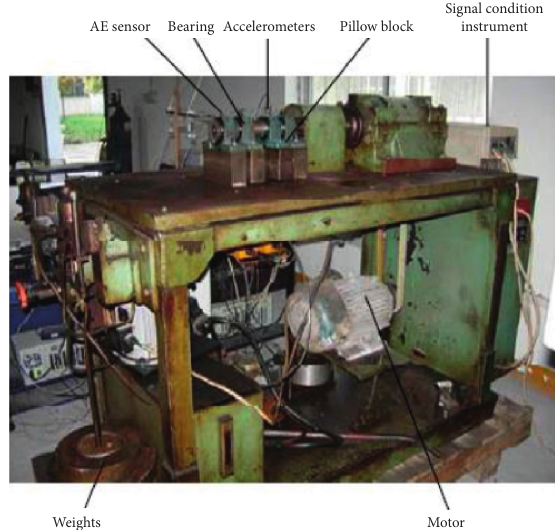
Figure 7: The ABLT-7 bearing test system used for the run to failure experiment.